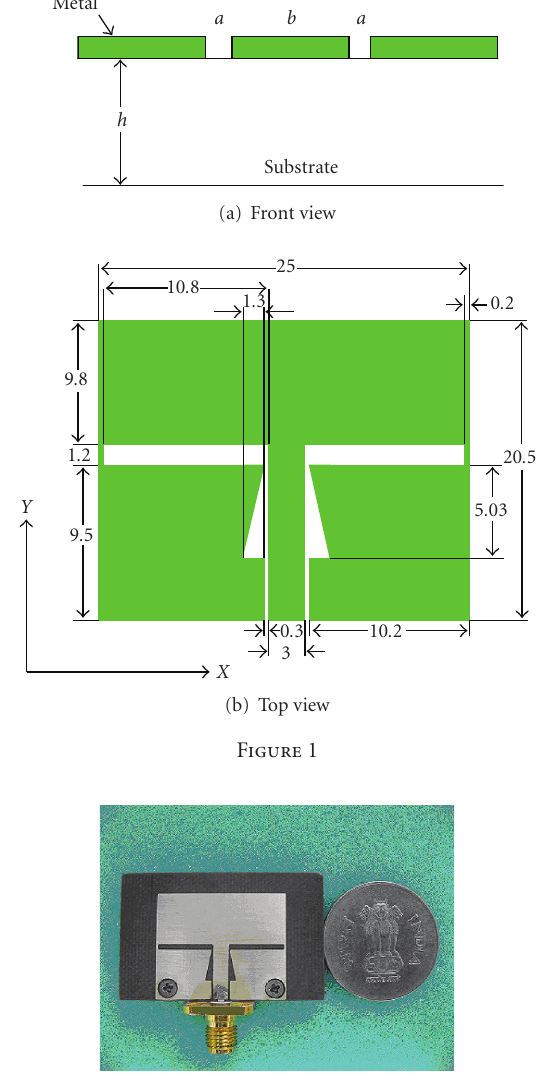
Figure 2: Photograph of the proposed antenna.